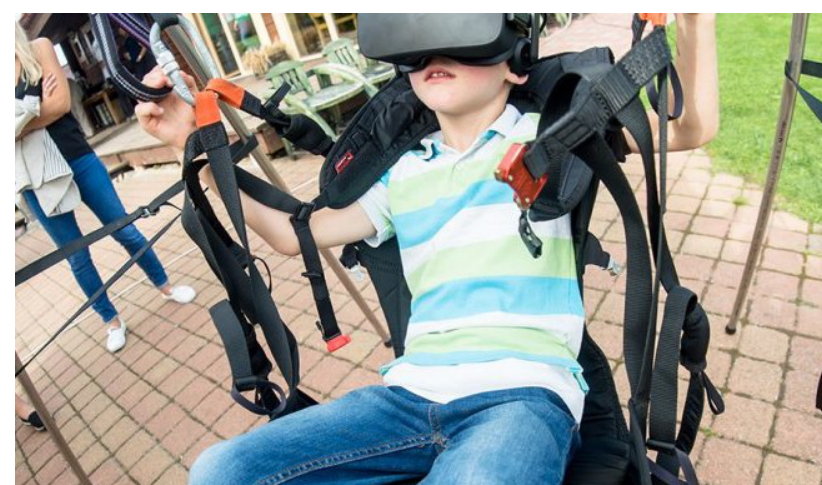
Figure 6. Snapshot of a game menu and game finish.